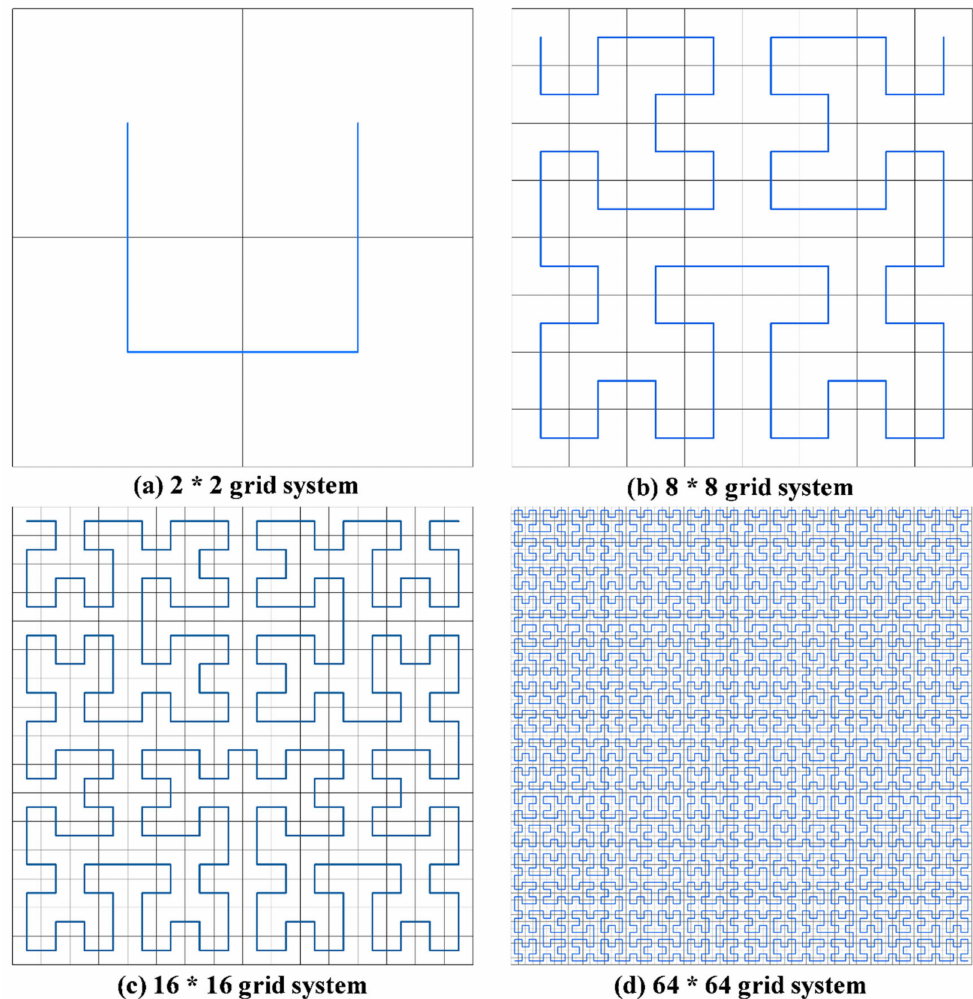
Figure A1. Hilbert curve in di ff erent grid